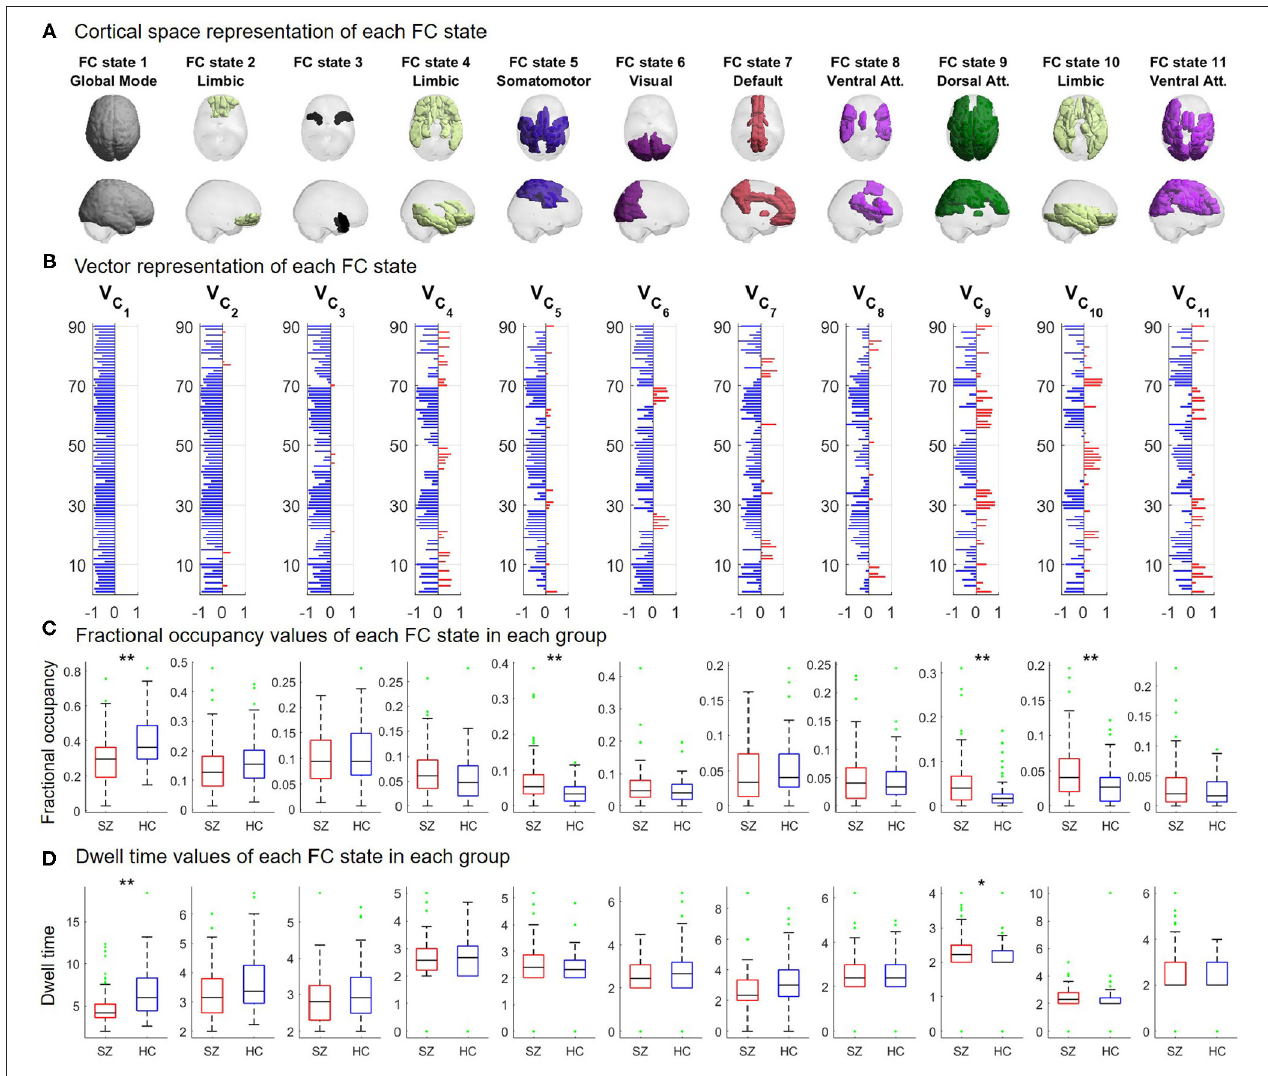
FIGURE 4 | Repertoire of FC states defined from phase coherence obtained from the clustering solution with K = 11 clusters. The FC states are arranged (left-to-right) according to decreasing estimated fractional occupancy. Each FC state is represented by a N × 1 centroid V C , with α ∈ { 1, ... ,11 } . (A) Cortical rendering of all brain α areas with positive values in V C . The functional network defined by Thomas Yeo et al. (2011) with which V C most significantly overlapped is indicated as subtitle. (B) α α Vector representation showing the N elements in V C , representing the contribution of each brain area to FC state α . (C) Boxplot of the fractional occupancy values for α each FC state for the SZ and HC groups. (D) Boxplot of the dwell time values for each FC state for the SZ and HC groups. Single and double asterisks indicate significant intergroup differences with p < α 2 and p < α 3 (one-tailed tests), respectively. Green points represent outliers, according to the Tukey criterion (Tukey, 1977).